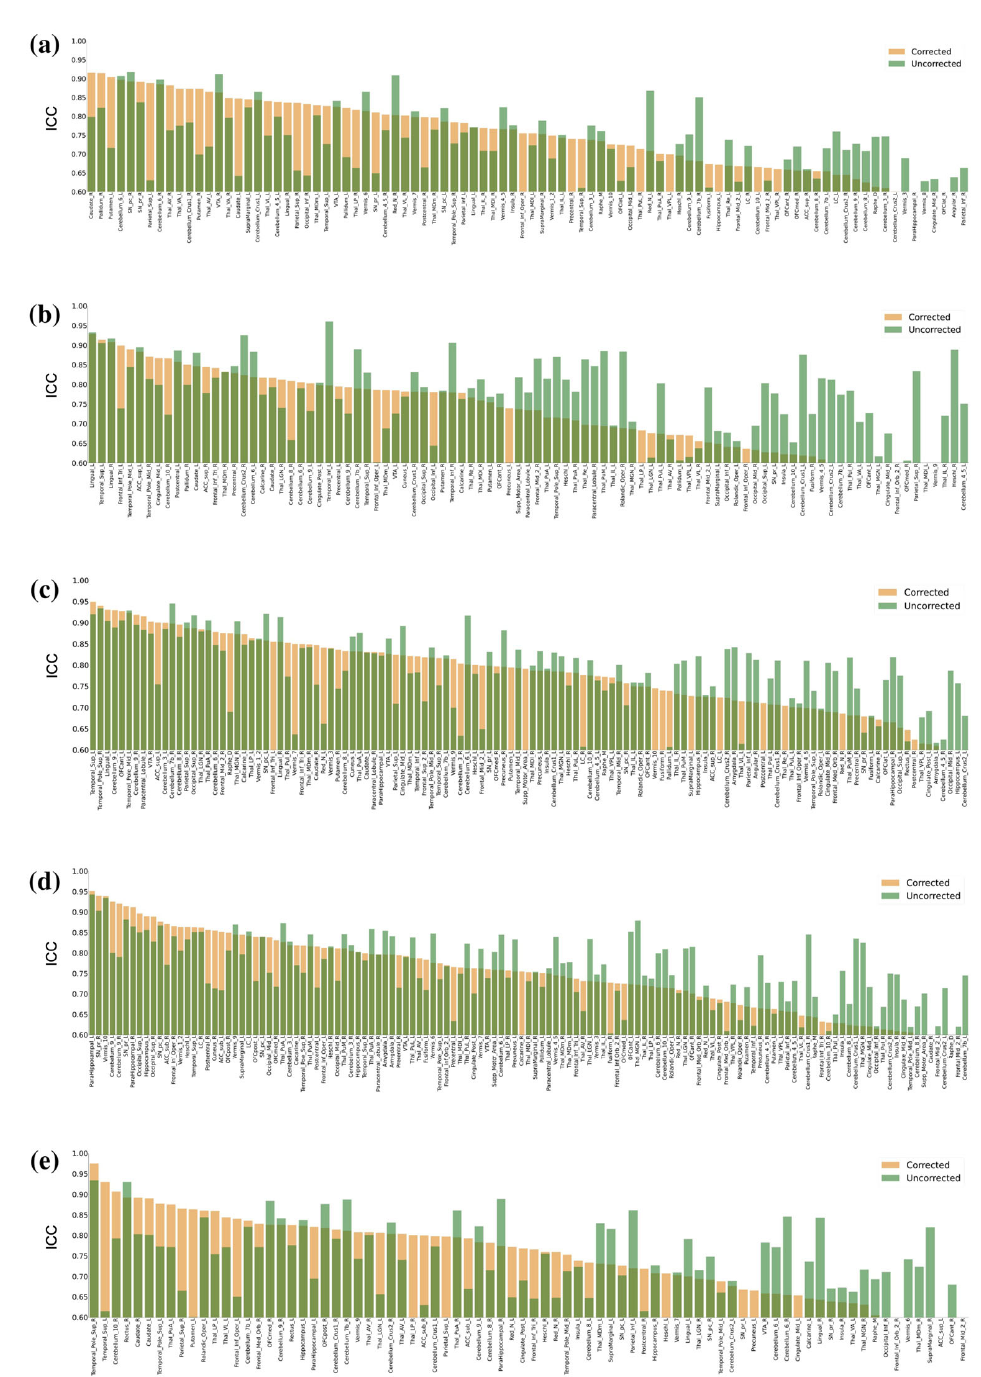
Figure 2. Plot of ICC values at all ROIs, corrected and uncorrected, through physiological noise removal. ( a ) Functional connectivity (FC), ( b ) fractional amplitude of low-frequency fluctuation (fALFF), ( c ) regional homogeneity (ReHo), ( d ) voxel-mirrored homotopic connectivity (VMHC), and ( e ) degree centrality (DC).